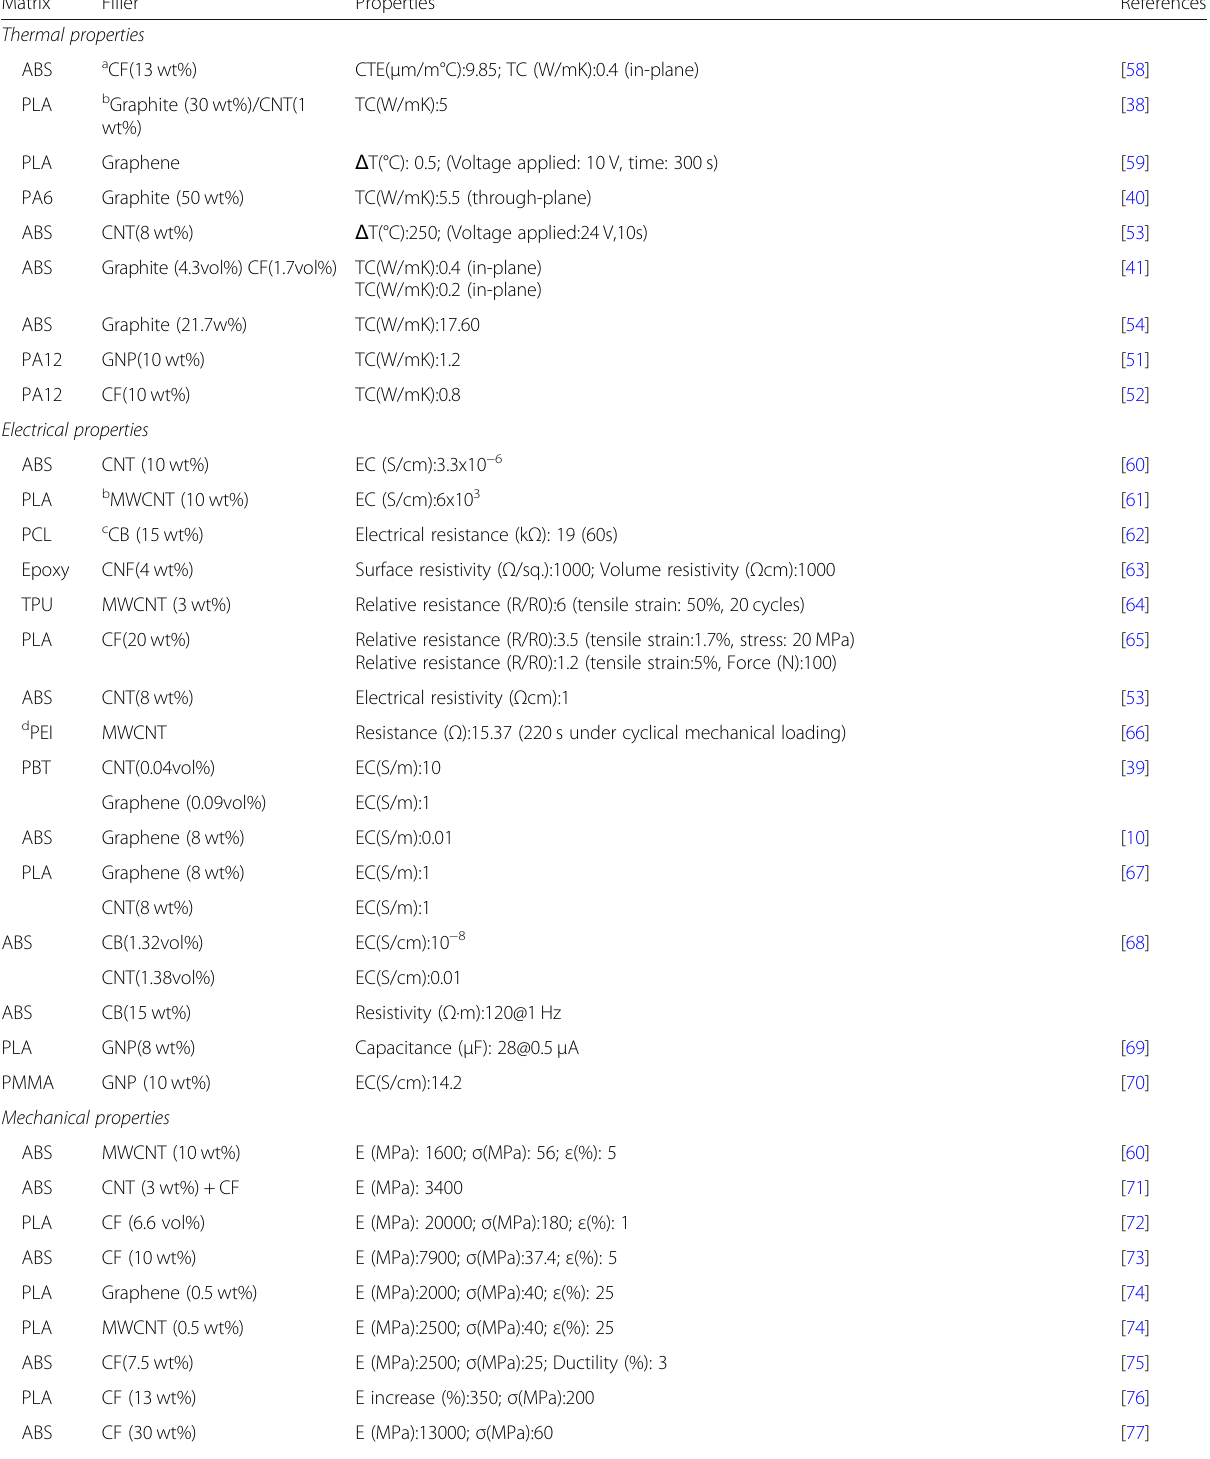
Table 1 Main properties of composites of polymers with carbonaceous additives prepared by FDM as reported in literature. a